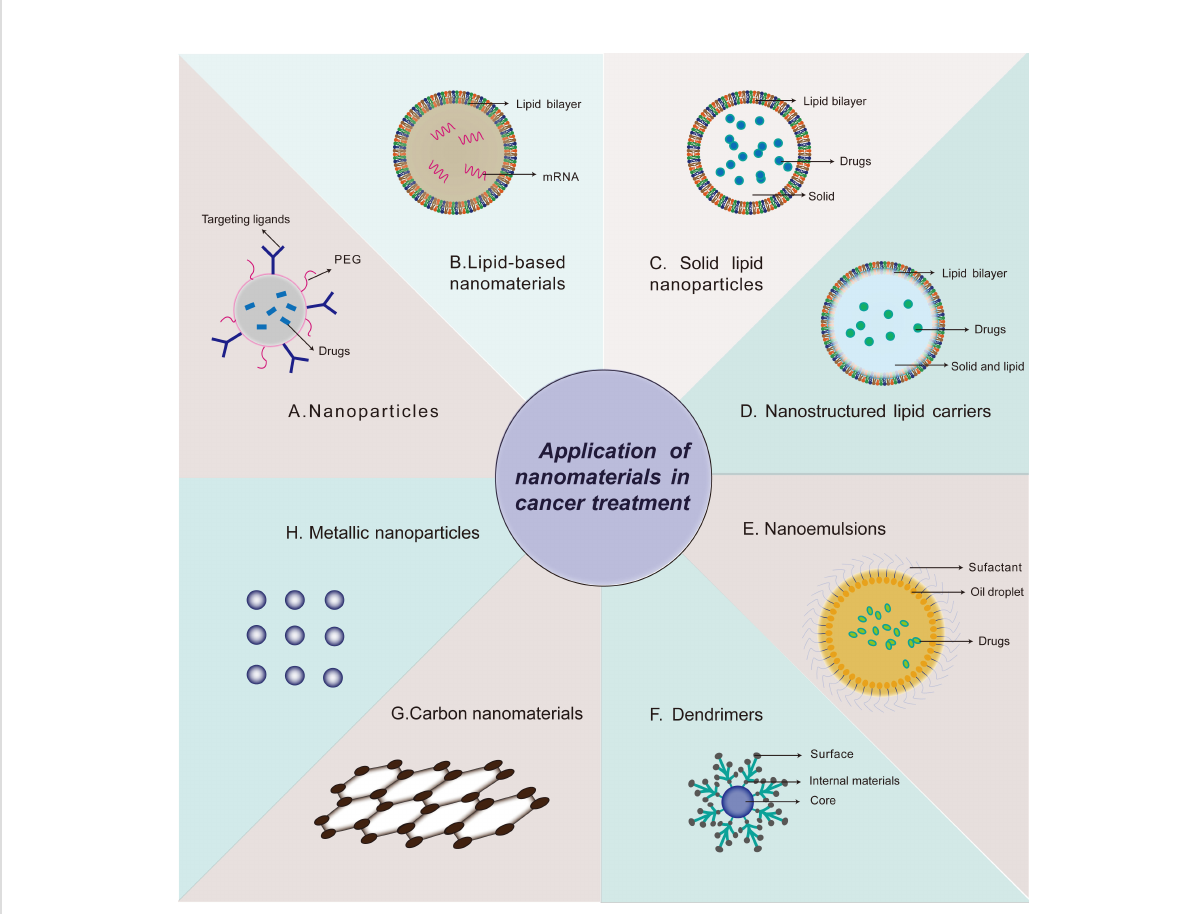
FIGURE 1 Strategies of nanomaterials applied in cancer treatment. Application of nanomaterials in cancer treatment, including Nanoparticles (A) , Lipid- based nanomaterials (B) , Solid lipid nanoparticles (C) , Nanostructured lipid carriers (D) , Nanoemulsions (E) , Dendrimers (F) , Carbon nanomaterials (G) , Metallic nanoparticles (H)